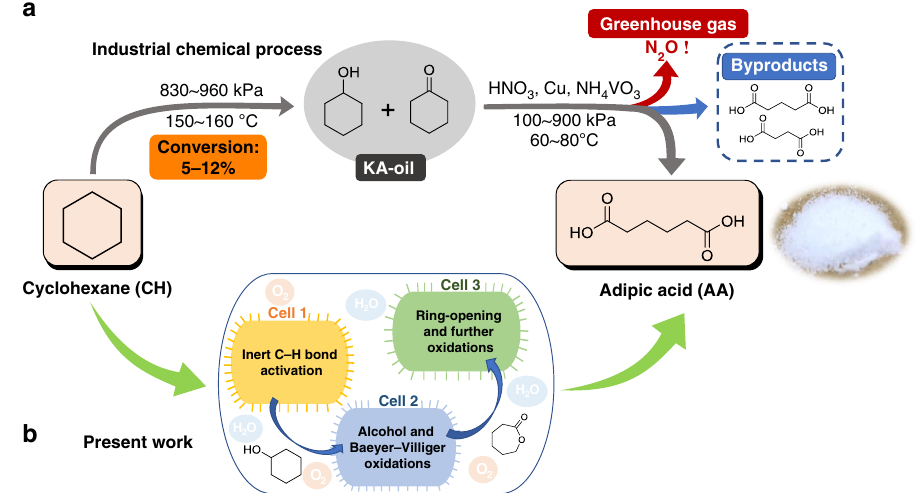
Fig. 1 Industrial chemical and designed biocatalytic processes for adipic acid (AA) production. a Current industrial process for synthesis of AA by multistage chemical oxidation from cyclohexane (CH). b designed one-pot biocatalytic route for synthesis of AA from CH using an Escherichia coli consortium, composed of three E. coli cell